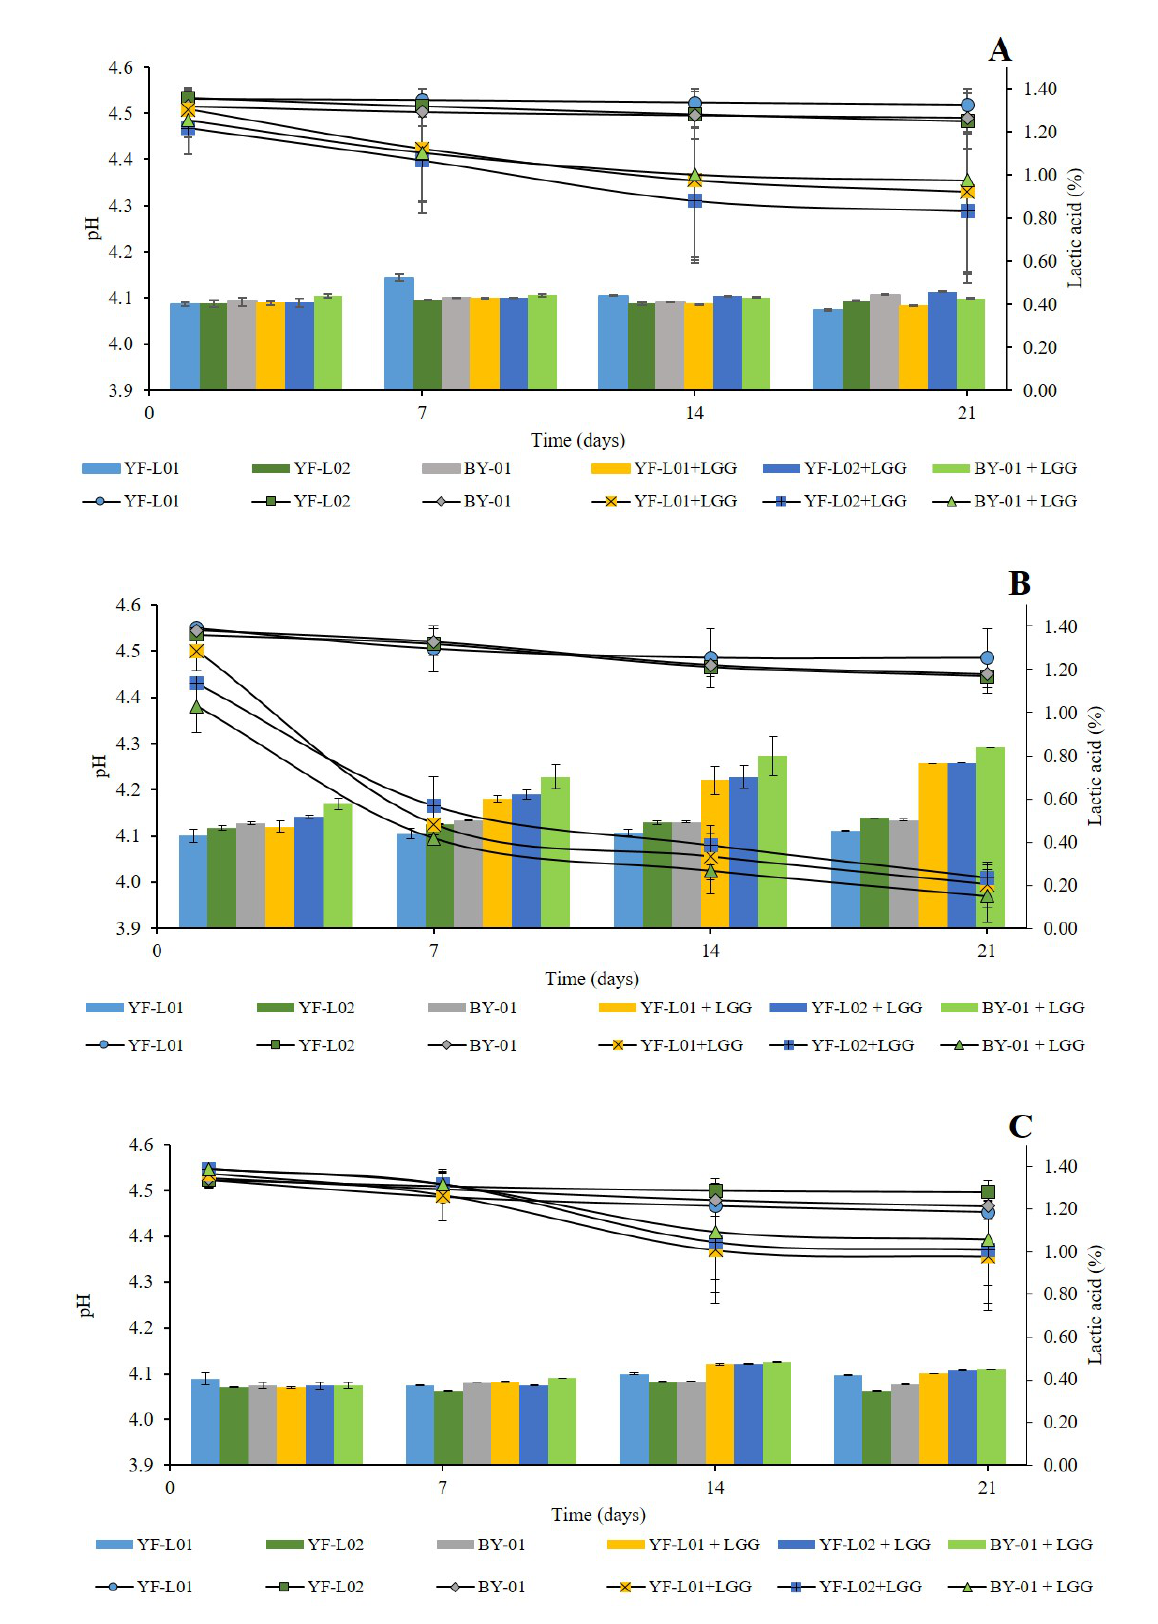
Figure 1. pH (left axis) and titratable acidity (TA) represented as lactic acid percentage (right axis) measurements of fermented ( A ) soy, ( B ) oat, and ( C ) coconut samples at day 1, 7, 14,